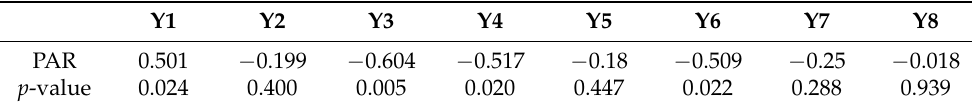
Table 3. The result of partial correlation